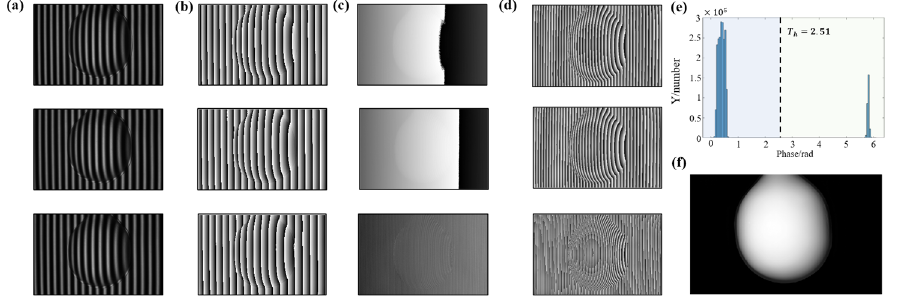
Figure 13. The calculation process of the proposed algorithm on an actual object. ( a ) Deformed fringe patterns. ( b) Wrapped phases obtained by PSP. ( c ) Phase difference maps. ( d ) Phase sum maps. ( e ) Histogram graph of | ϕ 12 d − ϕ 23 d | . ( f ) Final continuous phase Φ 123 s .